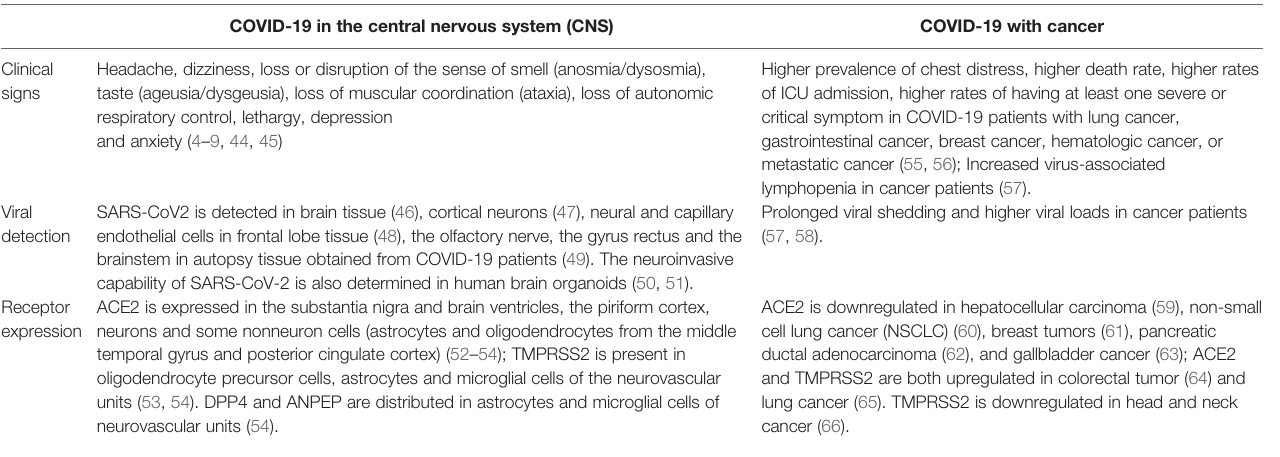
TABLE 1 | SARS-CoV-2 infection in the central nervous system and cancer. COVID-19 in the central nervous system (CNS) COVID-19 with